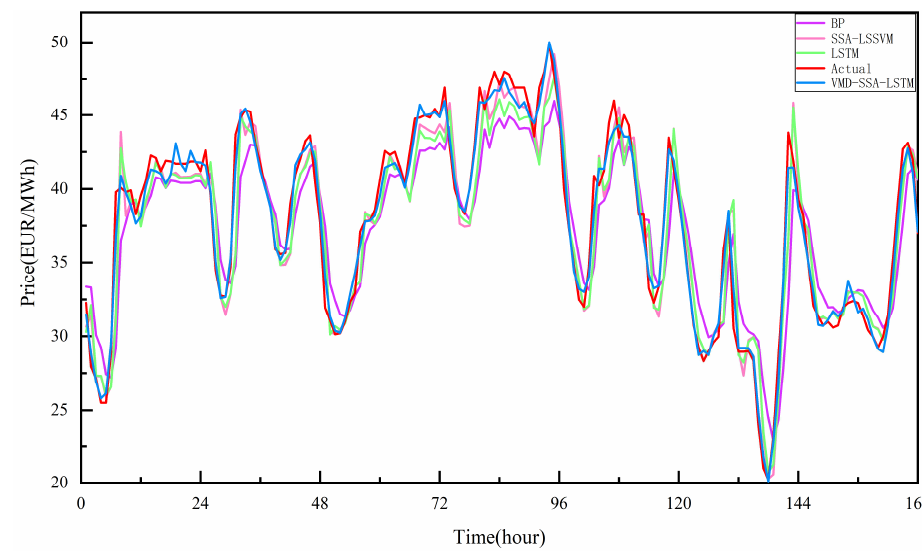
Figure 11. Curve of summer forecast results for Spain.